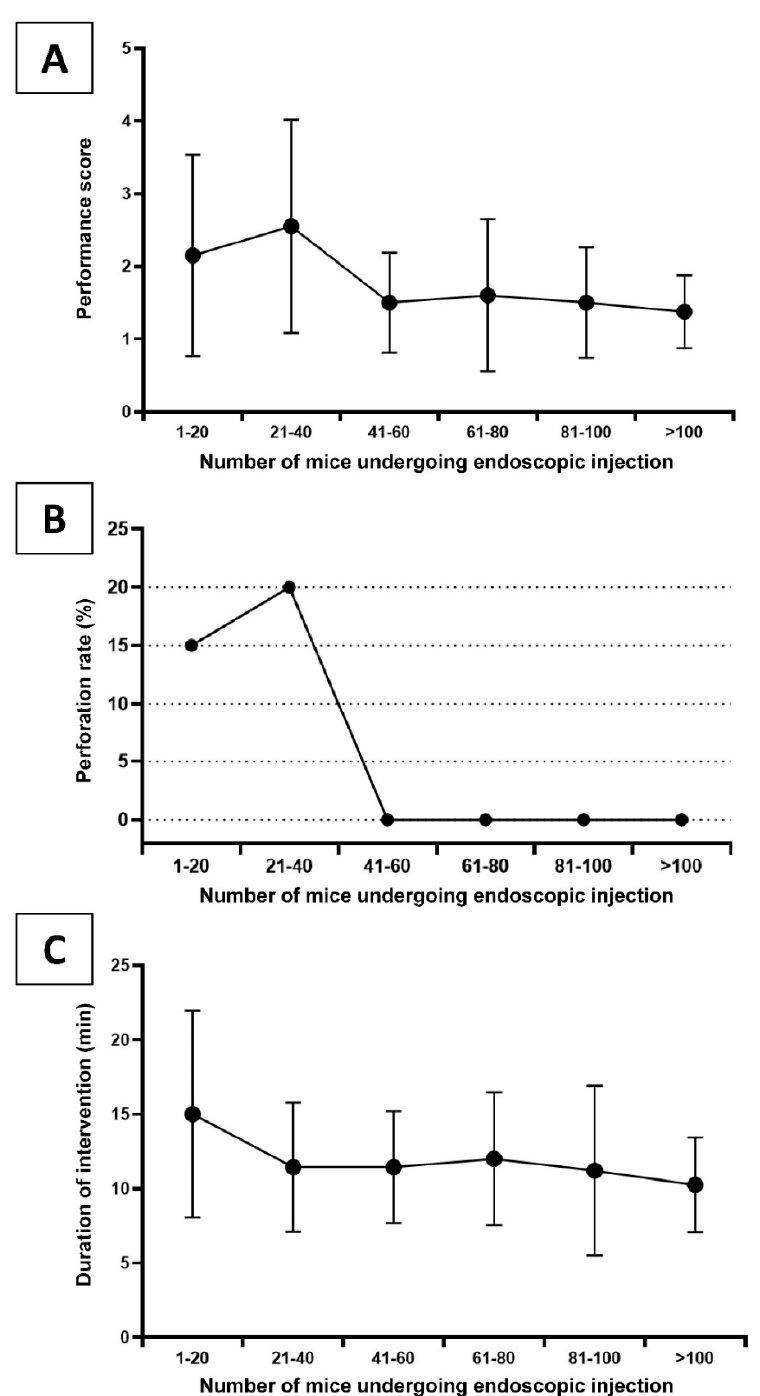
Figure 1. Learning curve during the establishment of the endoscopy-guided tumor cell implantation model showing ( A ) the mean performance score (number of injection attempts with a maximum of 4 attempts, 5 = failure defined as colon perforation or no successful lifting sign), ( B ) the perforation rate, and ( C ) the mean duration of an intervention for mice in chronological subgroups of 20 animals.